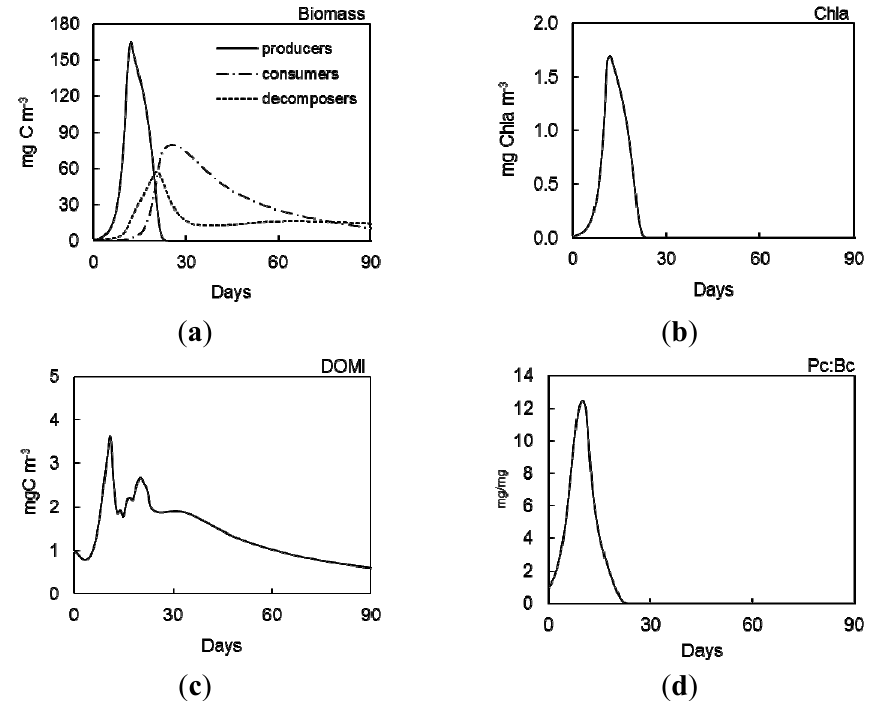
Figure 2. Results for ( a ) biomass of producers, consumers and decomposers; ( b ) chlorophyll a (Chla) concentration; ( c ) labile dissolved organic carbon; and ( d ) producers:decomposers